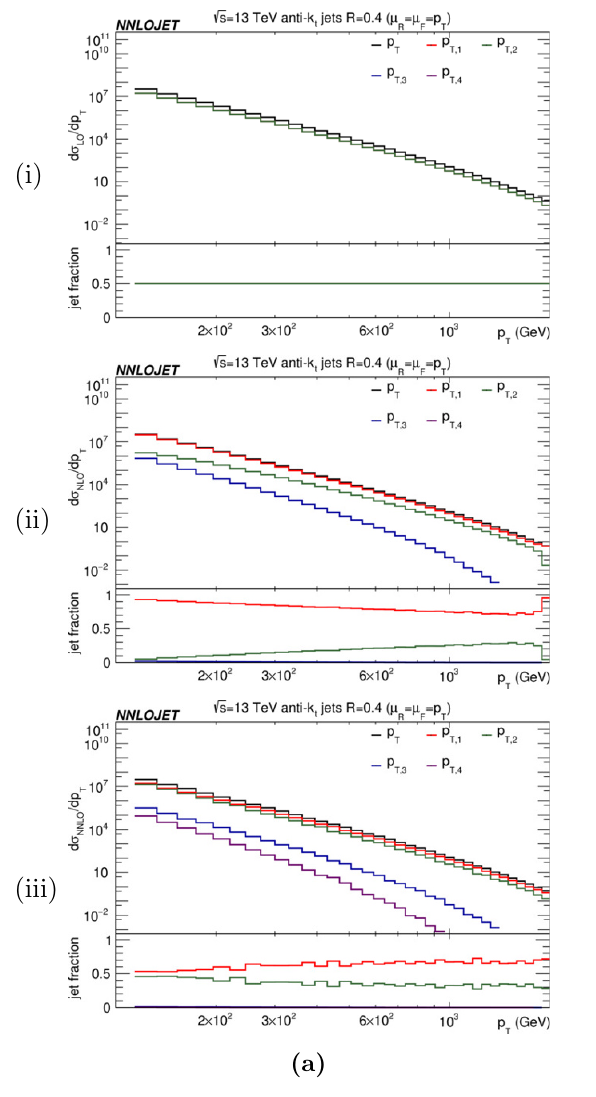
Figure 8 . Breakdown of single jet inclusive cross section integrated over rapidity into contributions from (cid:12)rst, second, third and fourth jet at (i) LO, (ii) NLO and (iii) NNLO evaluated for (cid:22) = p T for jet cone sizes (a) R = 0 : 4 and (b) R = 0 :